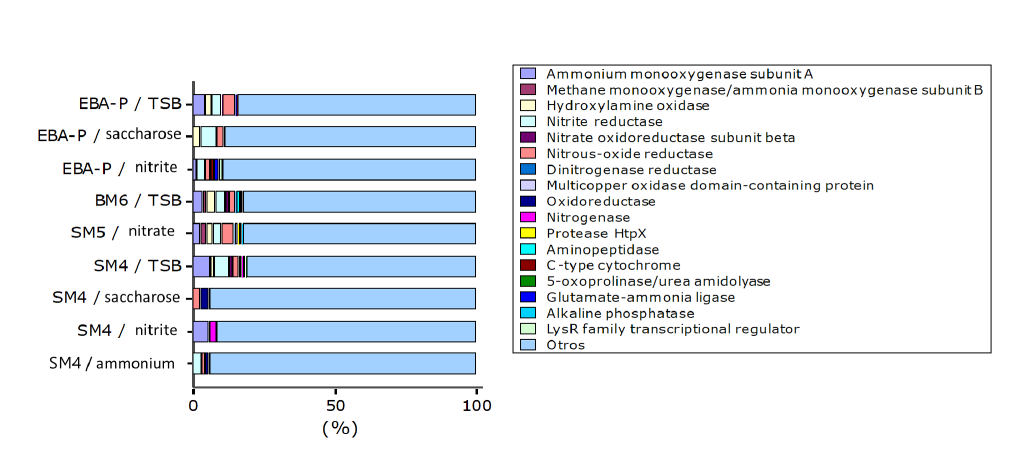
Fig. 2. Diversity of proteins (not absolute) expressed during the evaluation of heterotrophic nitrification capacity of the selected Bacillus